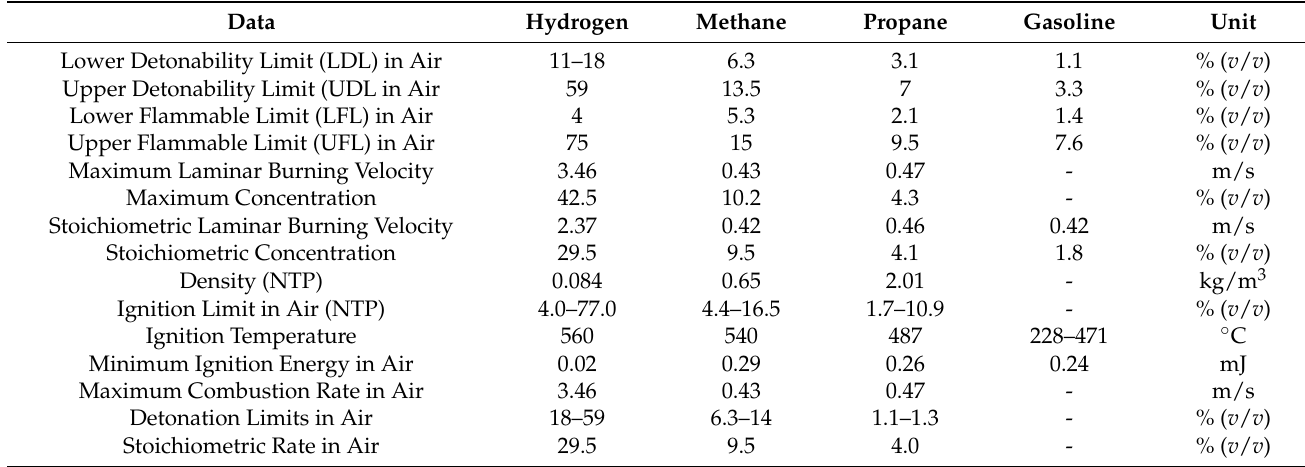
Table 2. Relevant characteristics and properties for safety of different gases and hydrogen. Adapted from Zhao et al. [6] and Taghavifar et al.